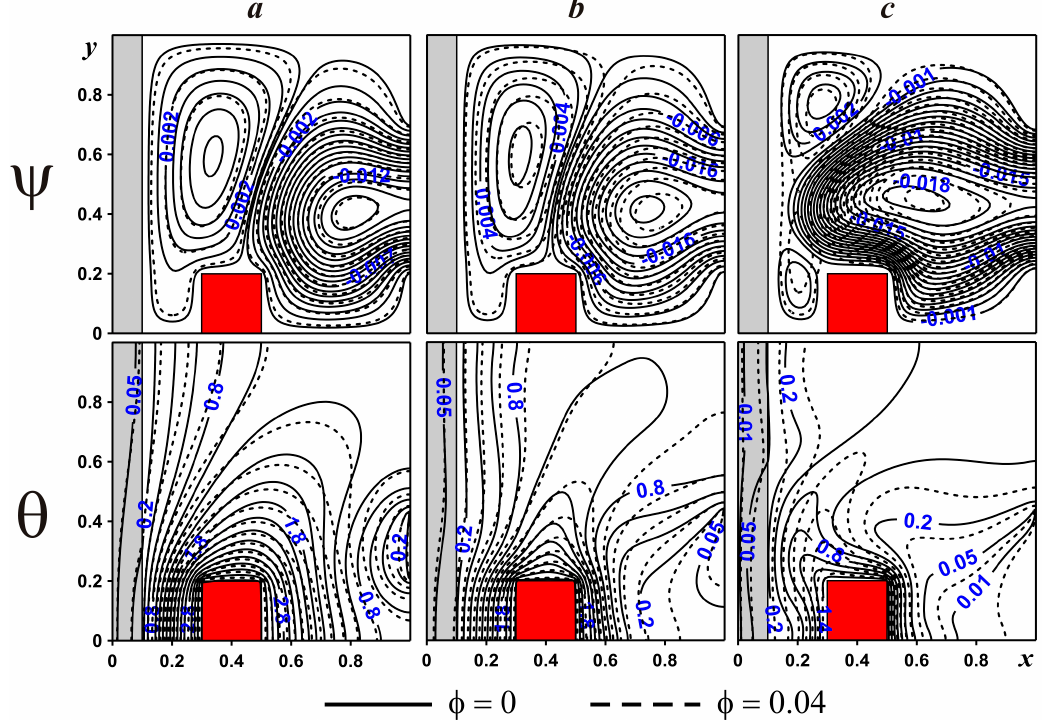
3 ( a ), Ra = 10 4 ( b ), Ra = 10 5 ( c r = 5, δ = 0.2: Ra = 10